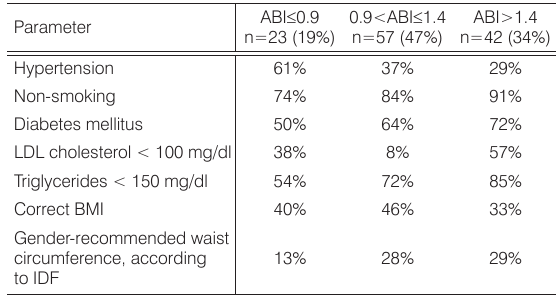
Table 3. The percentages of patients reaching therapeutic